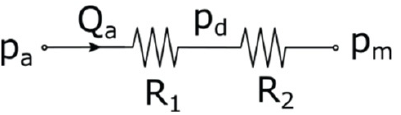
Figure 1. Panel A. Flowchart of data export. Curves were exported from RadiView to our dedicated, custom-made JAVA based software to calculate the derivative curves. Panel B. Calculation of δ dP n /dt. The upper panel shows the formula for the calculation of δ dP n /dt. The middle panel shows the original curves recorded without any modification, except for the zoom-in function. This allowed us to identify the exact same time-point with a cursor, where the FFR or RPR calculations were made. The lower panel shows the derivative curves of both the proximal and distal pressure traces with the same time resolution as that of the original curves. Abbreviations: FFR = Fractional flow reserve; δ dP n /dt = local amplitude around the dicrotic notch on the derivative curve of the distal intracoronary pressure trace; RPR = Resting pressure ratio.